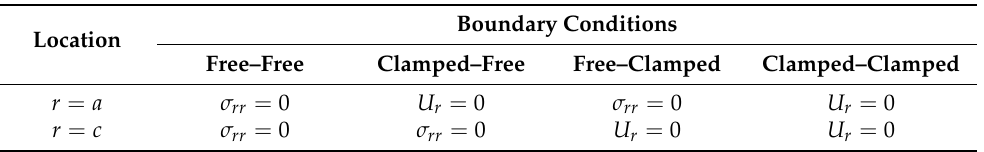
Table 1. List of considered mechanical boundary conditions at the inner ( r = a ) and outer ( r = c ) radii of the composite cylinder (Figure 1). Boundary Conditions Location Free–Free Clamped–Free Free–Clamped